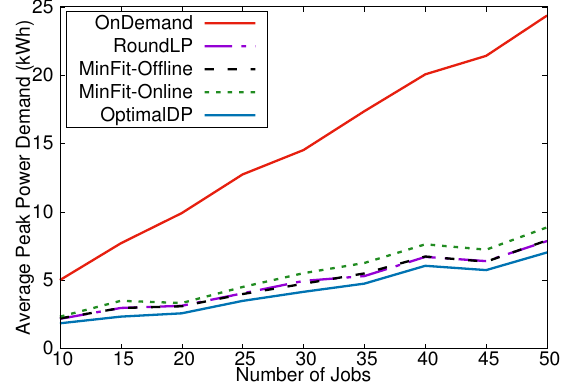
Figure 3. Performance of peak demand minimization (PDM) scheduling algorithms in a smaller scenario where the optimal solution can be